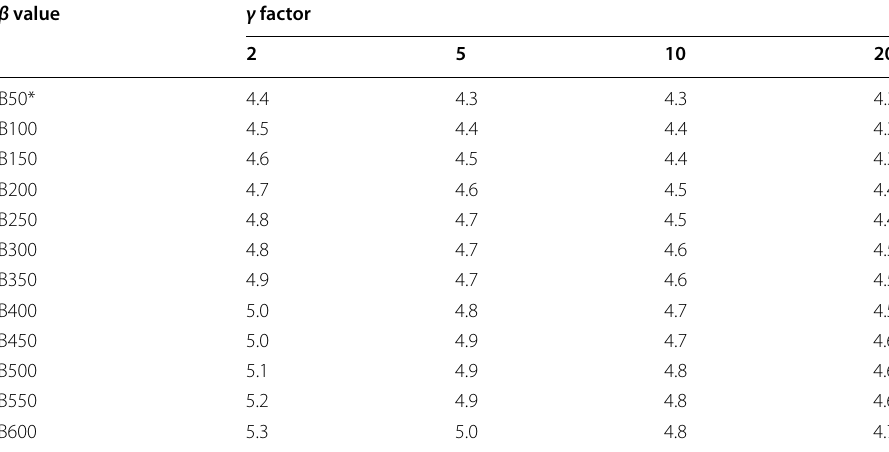
* B n indicates BPL reconstruction with β value of n